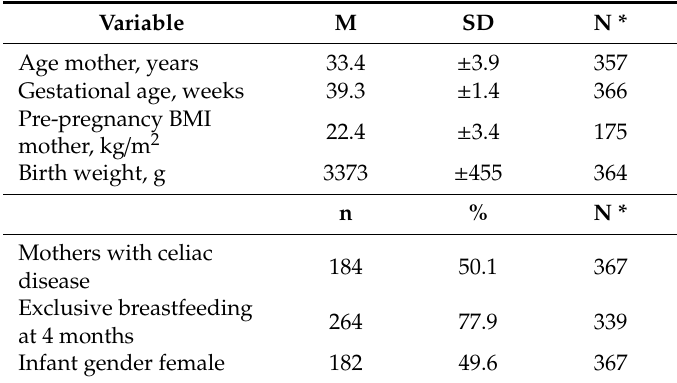
Table 1. Characteristics of participating mothers and their